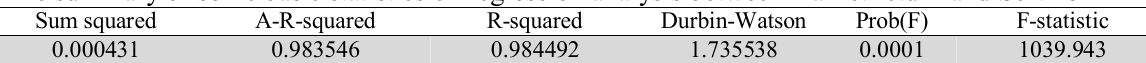
The summary of some basic statistics on regression analysis between market return and Sortino